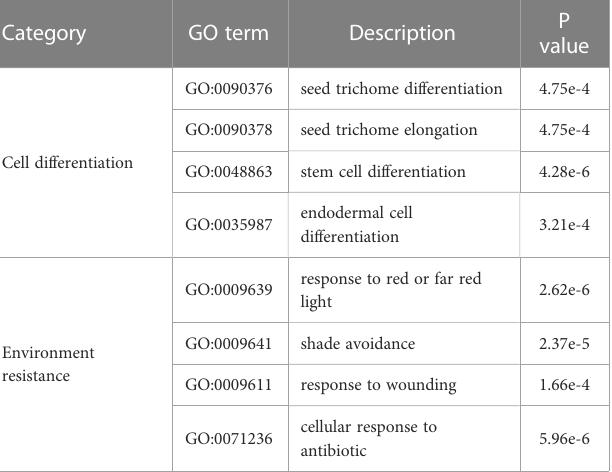
TABLE 2 GO Enrichment analysis result of the gene families unique to Melastoma .